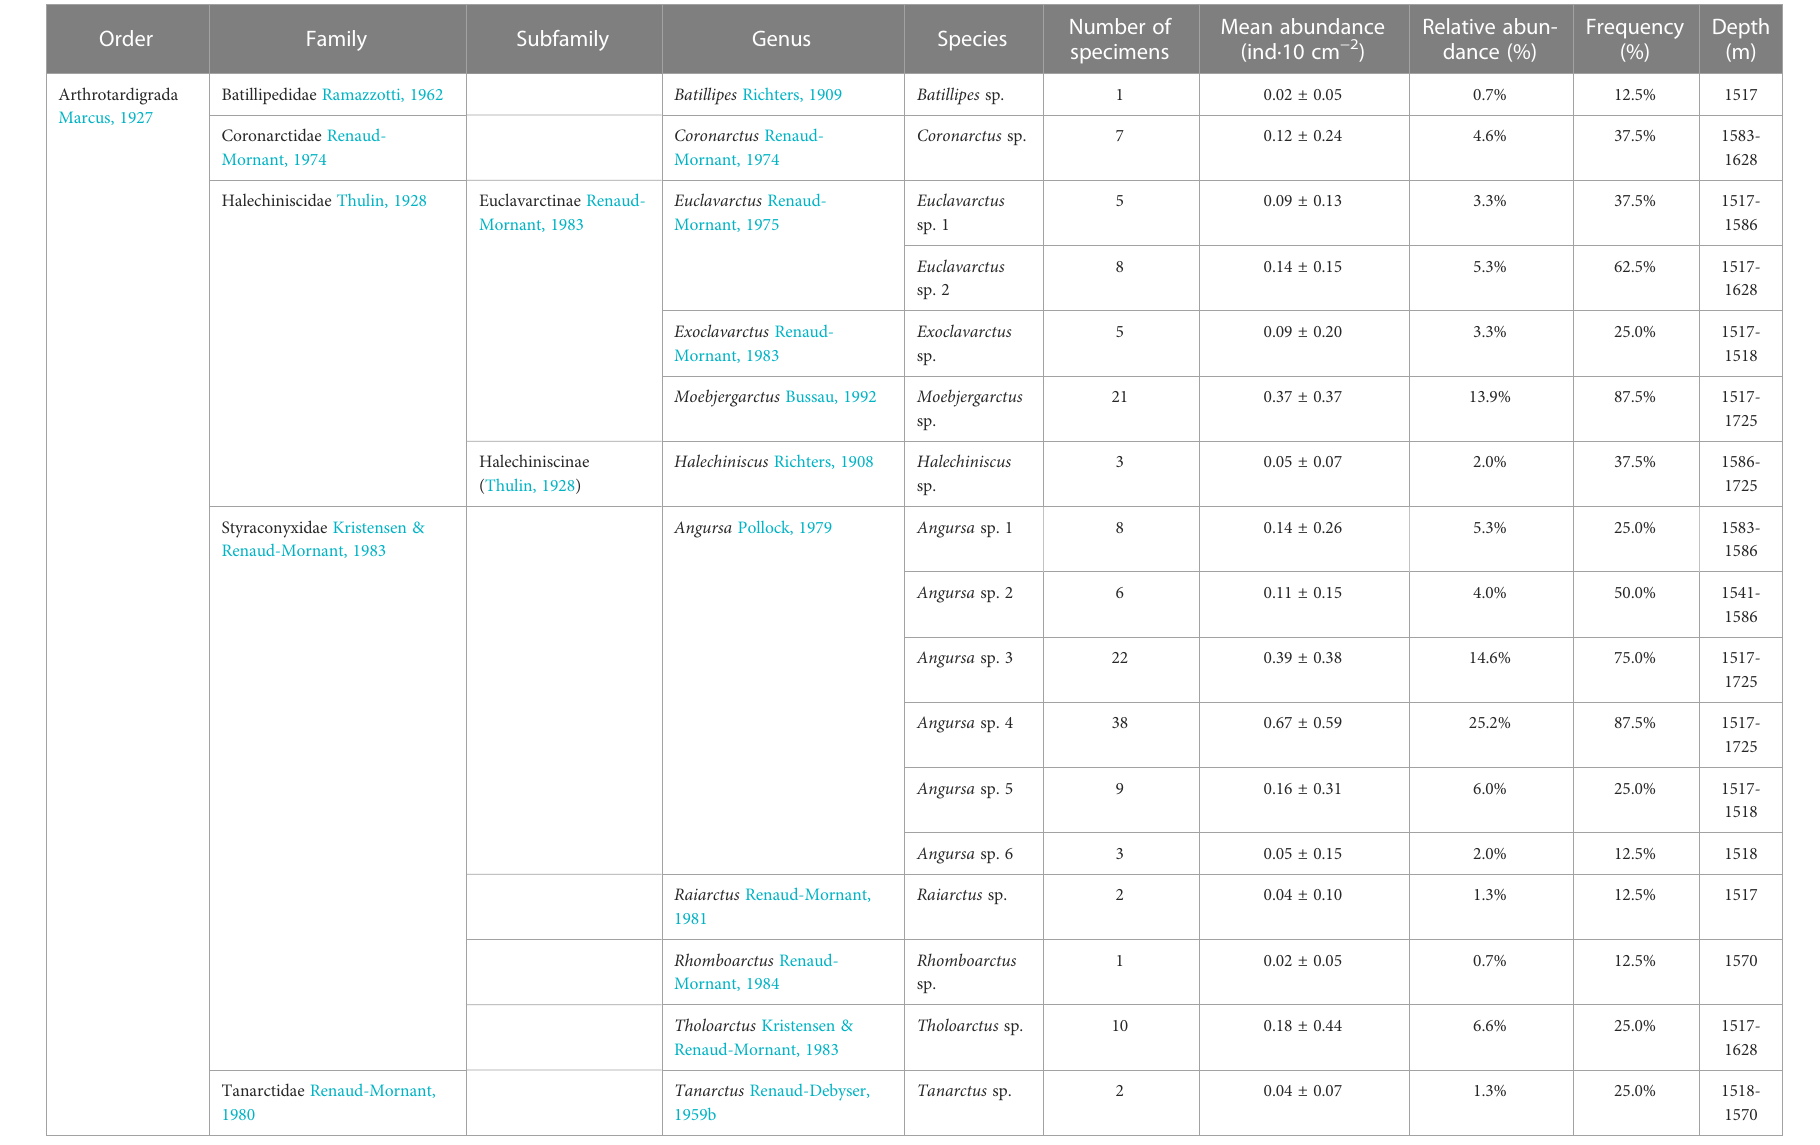
Relative abun- Frequency Depth Number of Mean abundance dance (%) (%) specimens (ind·10 cm − 2 )